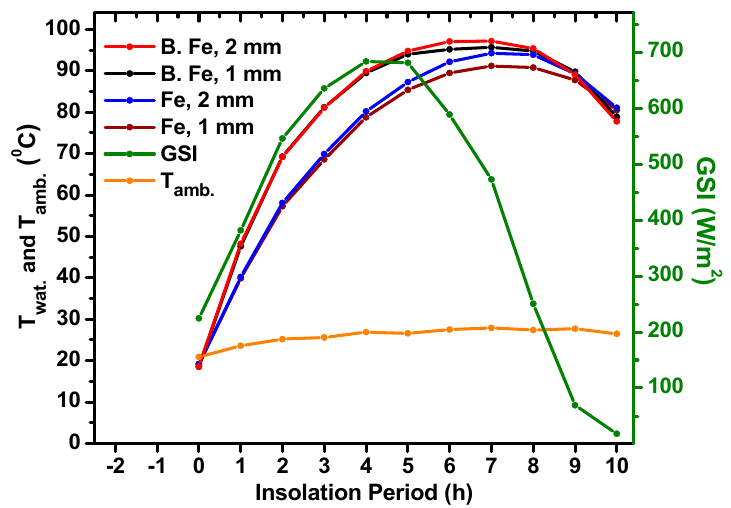
Figure 5. Water and ambient air temperatures (T wat . and T amb .) and global solar intensity (GSI) against insolation period, Fe and B. Fe containers with two thicknesses, 1 m and 2 mm; starting time: 8:00 a.m.; sunny day; date: 11/10/2021, Amman, Jordan.